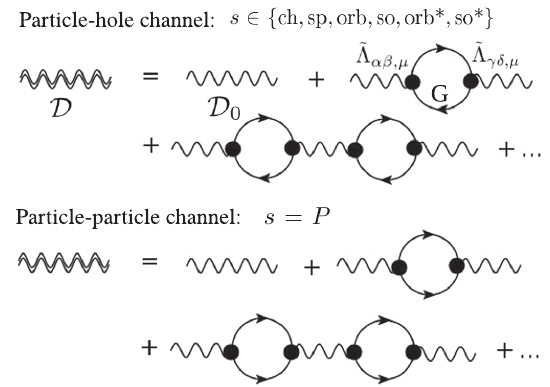
FIG. 8. Diagrammatic representation of the Dyson equation in Eq. (F5). The double wavy line and the wavy line denote the dressed bosonic propagator D and the bare bosonic propagator D G . The circle 0 . The solid line denotes the Nambu propagator ˜ Λ denotes the three-leg vertices